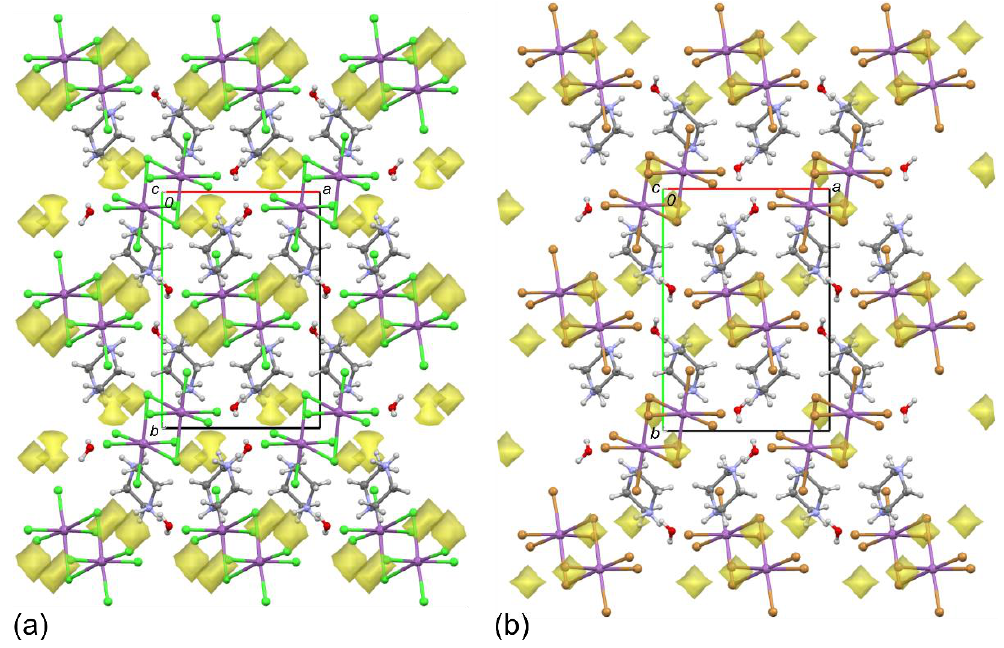
Figure 1. Packing diagrams of 1 ( a ) and 2 ( b ), along the c -axes, at 85 K. The intermolecular space accessible to the probing sphere of radius 0.70 Å and the grid spacing of 0.58 Å is indicated in yellow. The void volume is: 1.3%, 16.66 Å 3 and 0.5%, 7.85 Å 3 for 1 and 2 , respectively.